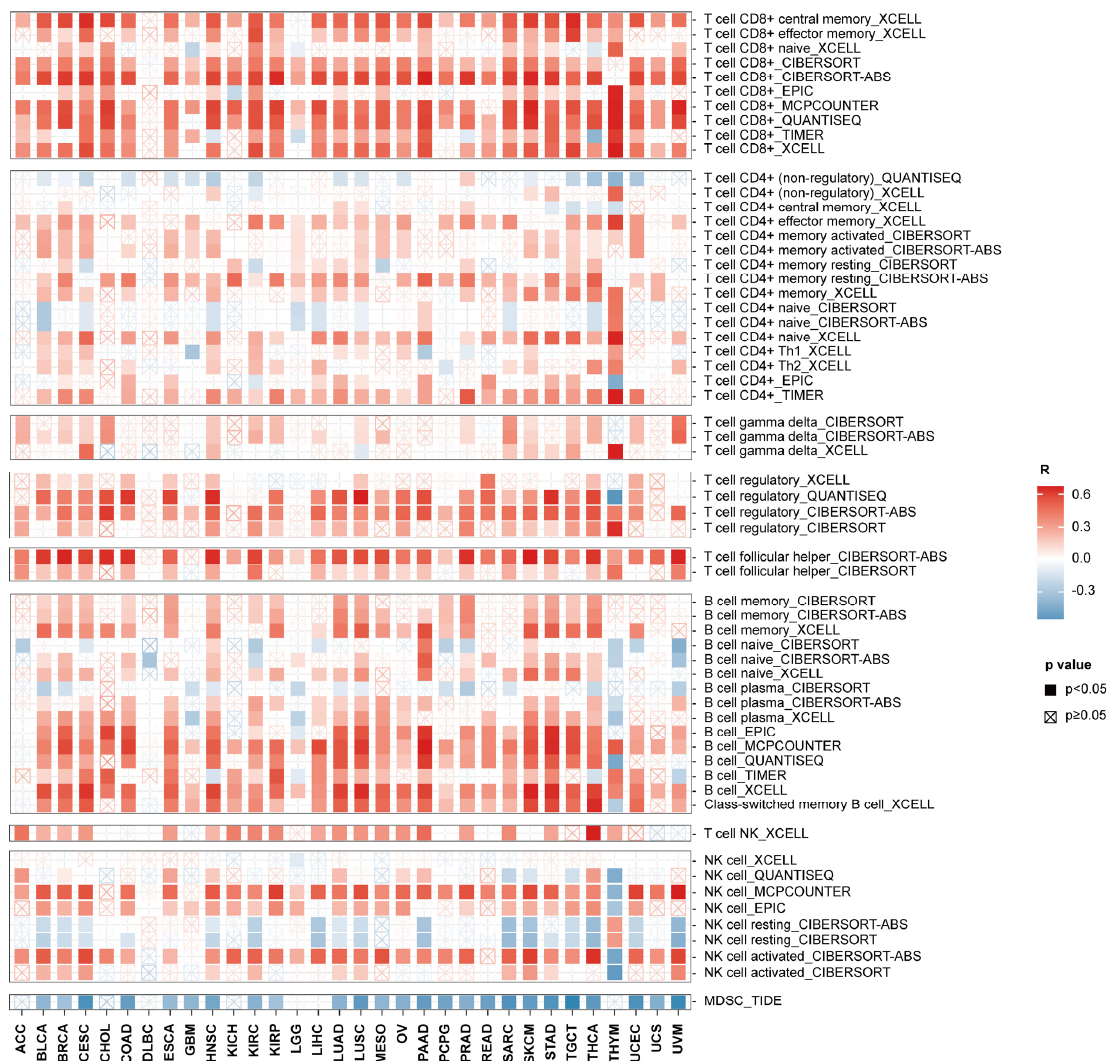
Figure 7. The Spearman correlations of ACAP1 expression with immune cell infiltration across 32 cancer types in TCGA.